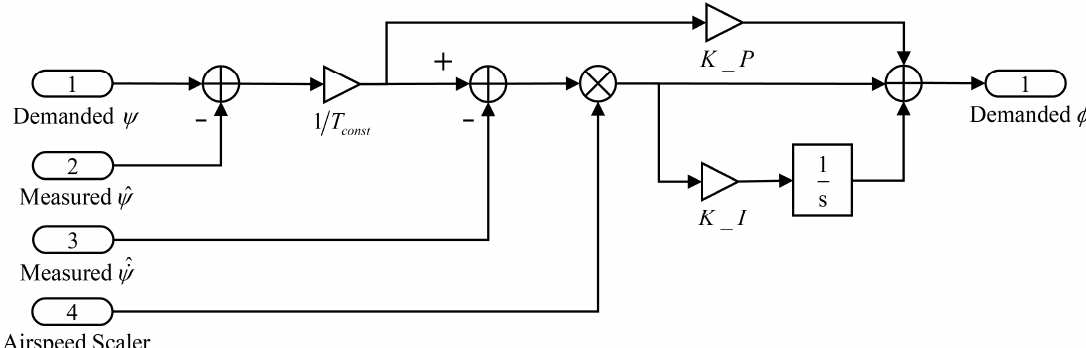
Figure 10. Level navigation heading control loop schematic diagram.